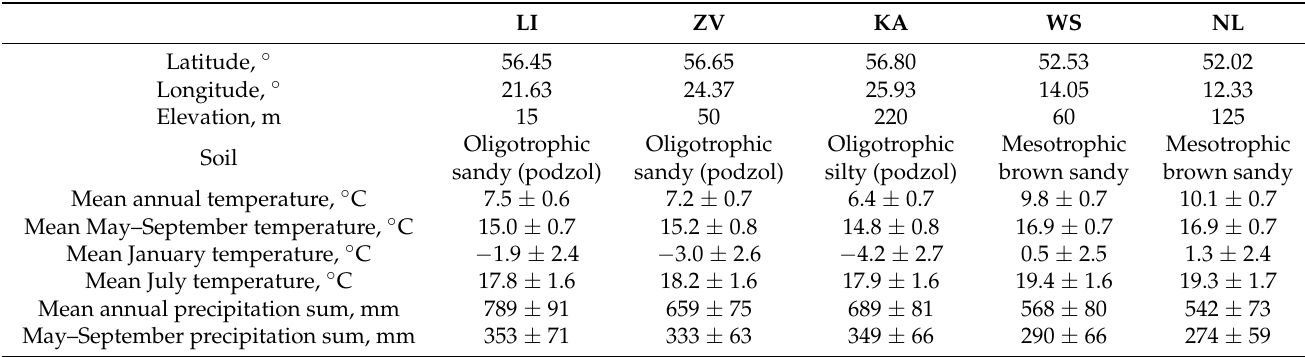
Table 1. Location and general climatic description (means ± standard deviation for the period 1988–2017) of the studied trials of Scots